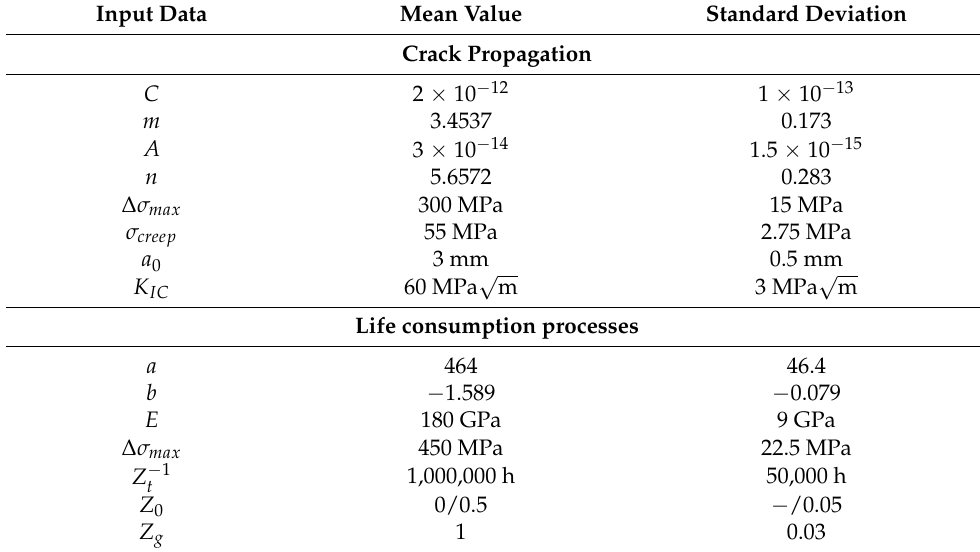
Table 1. Mean values and standard deviations of quantities affecting crack propagation and life- consumption